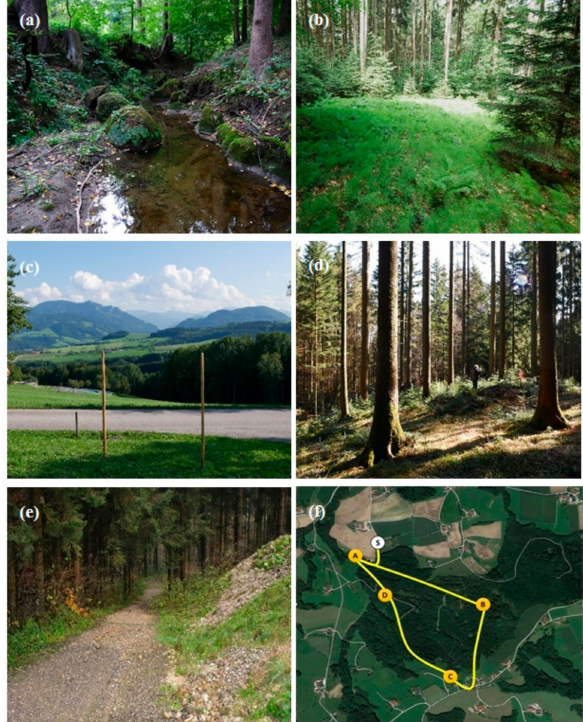
Figure 1. Impressions of the selected places in the forest: ( a ) Mossy stones (A in the map); ( b ) Fern glade (B); ( c ) Outlook (C); ( d ) Forest glade (D); ( e ) Start / end of the forest path (S); ( f ) Map of the